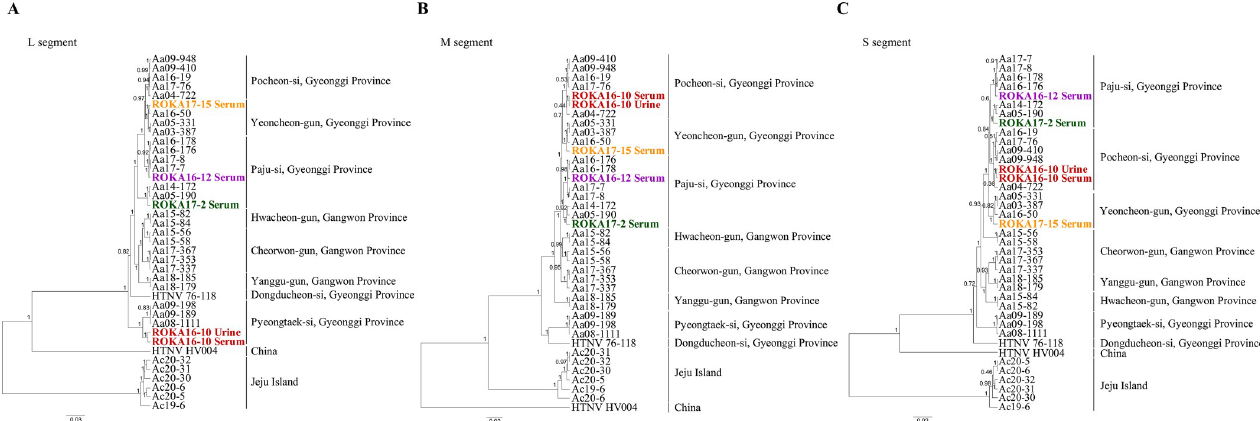
Fig 2. Phylogenetic analysis of whole-genome sequences of Hantaan virus (HTNV) L, M, and S segments from patients with hemorrhagic fever with renal syndrome (HFRS). Phylogenetic relationships of the whole-genome sequences of the HTNV L, M, and S segments were inferred using Bayesian inference in BEAST (v1.10.4), using the GTR+G+I, GTR+G, and TN93+G models based on 6,530 nt of the L segment (A), 3,616 nt of the M segment (B), and 1,696 nt of the S segment (C), respectively. After running the Markov chain Monte Carlo analyses until adequate sample sizes (ESS > 200) were obtained, TreeAnnotator (v2.5.4) was used to summarize a maximum clade credibility tree from the posterior tree distribution, using a 25% burn-in. Numbers along branches are posterior probability. Posterior probabilities of 0 are induced by the rounding of values to 2 decimal places. The scale bar represents nucleotide substitutions per site. The following hantaviral sequences were included in the analysis: Aa03-387 (L segment, KT934958; M segment, KT934992; S segment, KT935026), Aa04-722 (L segment, KU2071740; M segment, KU207182; S segment, KU207190), Aa05-190 (L segment, KT934959; M segment, KT934993; S segment, KT935027), Aa05-331 (L segment, KT934962; M segment, KT934996; S segment, KT935030), Aa08-1111 (L segment, KY594712; M segment, KY594715; S segment, KY594718), Aa09-189 (L segment, KY594713; M segment, KY594716; S segment, KY594719), Aa09-198 (L segment, KY594714;